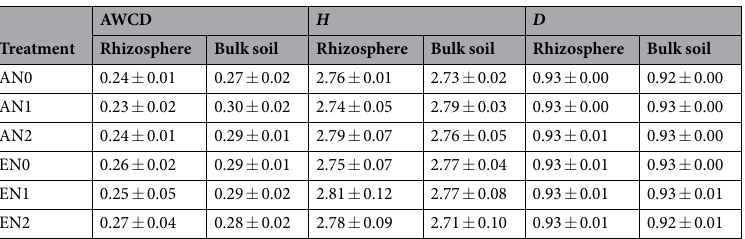
Table 4. Average well color development (AWCD) and functional diversity (Shannon index ( H ), and Simpson index ( D )) of the soil microbial communities in the treatments in the rhizosphere and bulk